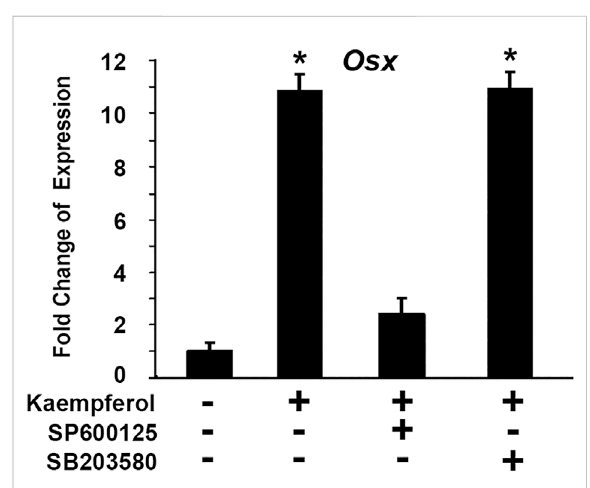
FIGURE 11 Kaempferol-induced OSX activation is mediated through JNK kinase pathway. Gene expressions were determined via qRT- PCR with or without kaempferol stimulation. The RNA level from the control group was normalized to a value of 1. *: A star indicates statistical signi fi cance compared to control group